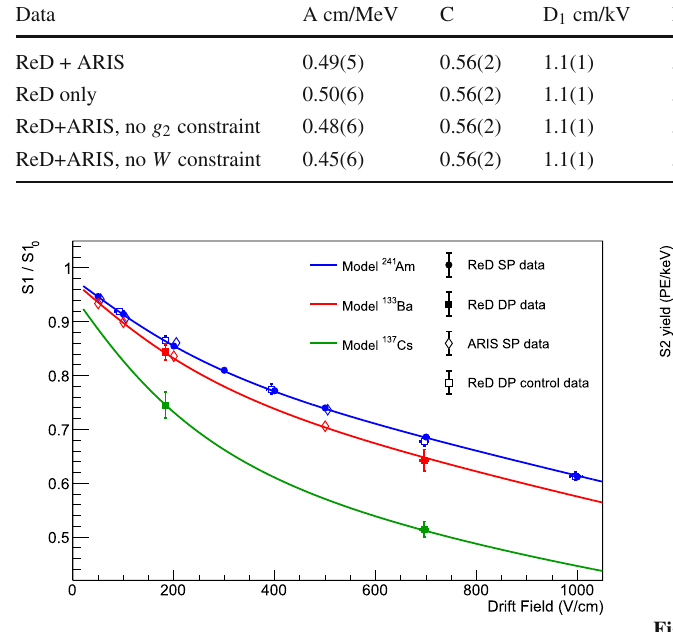
Fig. 17 Ratio of S1 signal at E d > 0 to that at null field ( S 1 / S 1 0 ) as a function of E d , from ReD single- and double-phase (DP) measurements with 241 Am, 133 Ba and 137 Cs sources, as well as ARIS single-phase (SP) measurements. Data points from ARIS are only available up to 500 V/cm. The curves show the results of a combined fit using both S1 andS2datatothemodifiedDoke–BirksparameterisationofEqs.11and 12 for an energy deposit of 59.54 keV ( 241 Am, blue), 81 keV ( 133 Ba, red), and an average energy deposit of 400 keV ( 137 Cs Compton edge, green). Fit parameters are given in Table 2 (‘ReD + ARIS’). ReD 241 Am